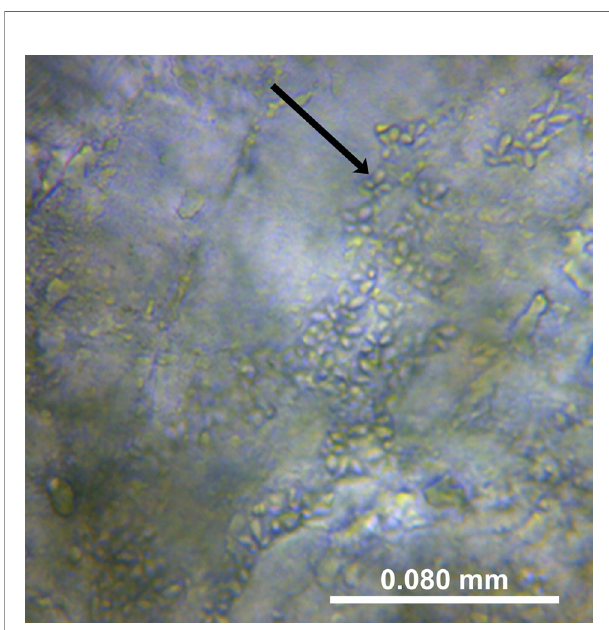
FIGURE 2 | A photo from a wet smear of Kudoa thyrsites spores from the soft mackerels examined. The muscle is partially degraded by the cathepsin enzyme; magni fi cation 400x.